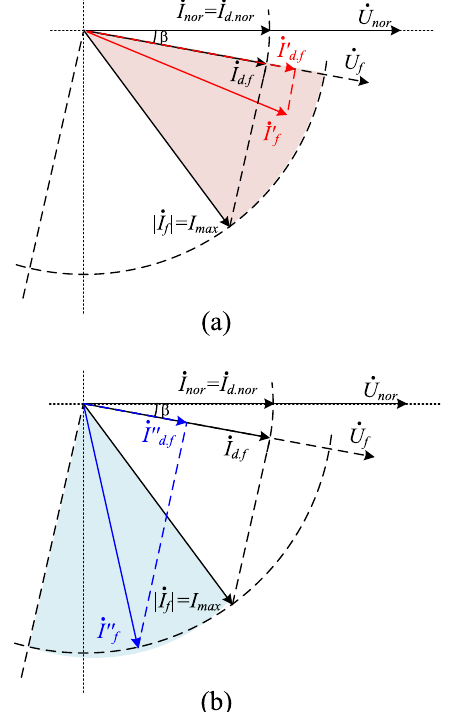
Fig. 2 Output current phasor of IIDG: a When the voltage drop is small; b When the voltage drop is